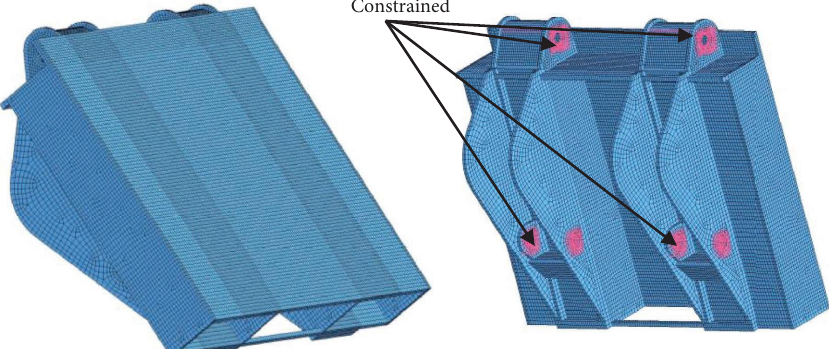
Figure 6: Te fnite element model of the tail beam.